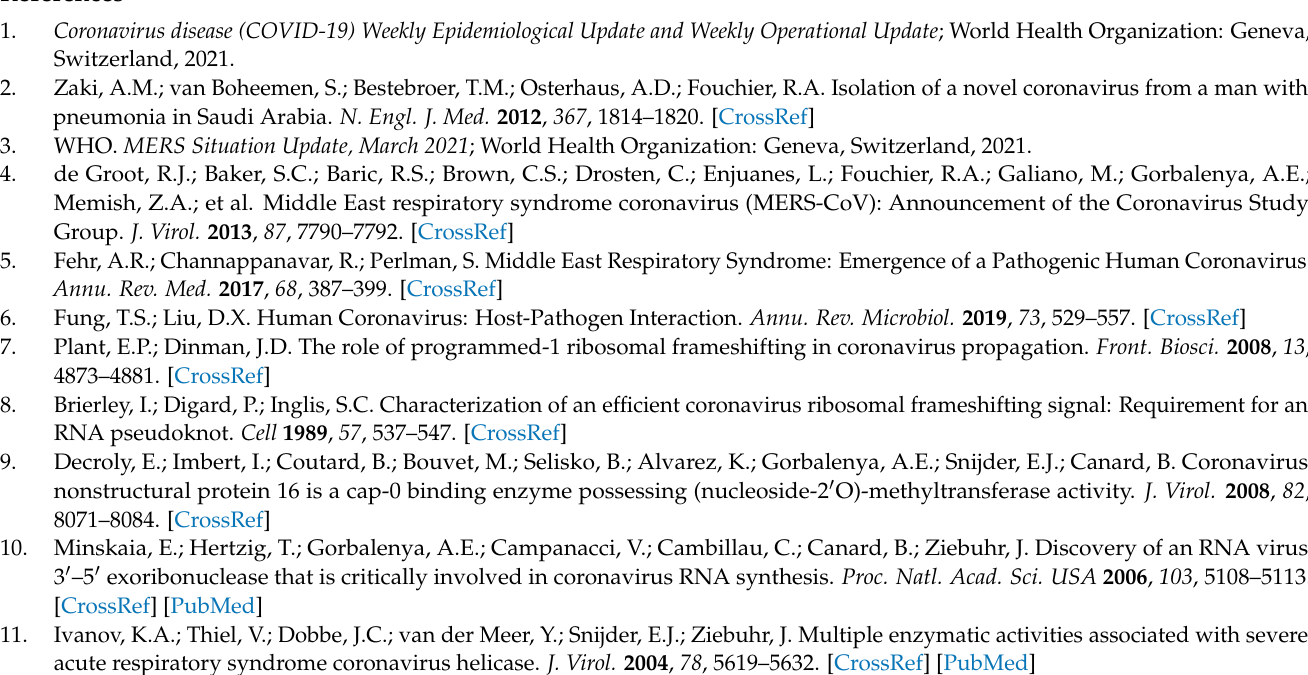
Figure S2. Dose-dependent inhibition of the SARS-CoV-2 frameshifting by KCB261770, Figure. S3. The effect of anisomycin on MERS-CoV frameshifting, Table S1. Small molecules that have been reported